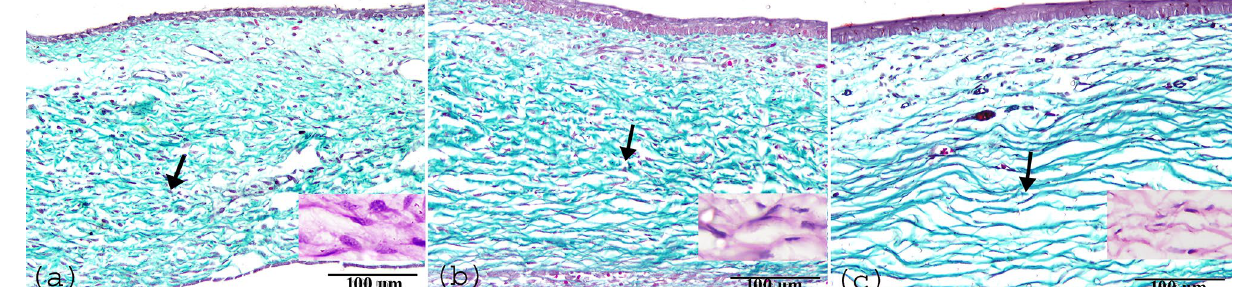
Figure 2. Paraffin sections showing postnatal development of limbal stroma stained with Crossmon’s Trichrome ( a ) At PND7, ( b ) PND15, and ( c ) at PND30 showing the collagen fibers in the inner fibrous layer were more orderly organized with age (black arrow). Note the shape of the keratocytes nucleus transformed from oval to flat (H&E